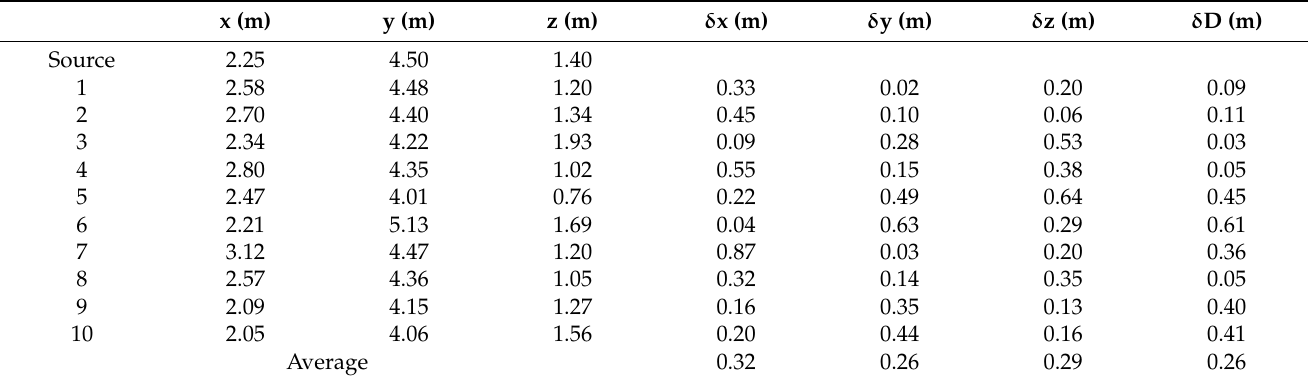
Table 4. Preliminary test results with the tetrahedral